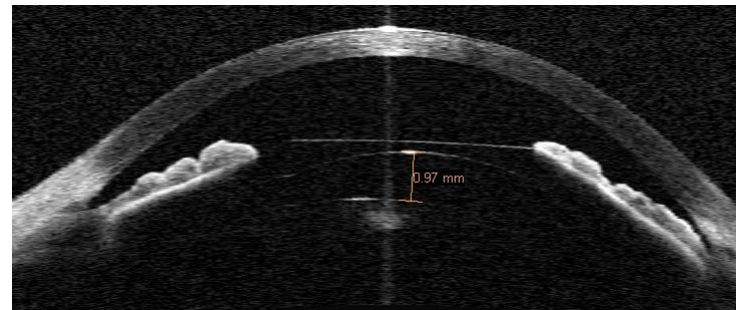
Figure 1. Anterior segment optical coherence tomography of an eye, implanted with a myopic ICL, exhibiting a 970 µm vault.